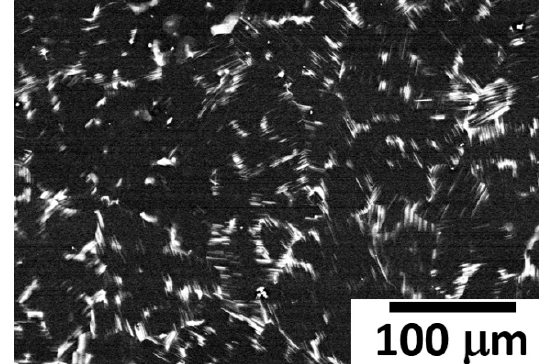
Figure 1. Back-scattered image of the as-cast GWZ31alloy.